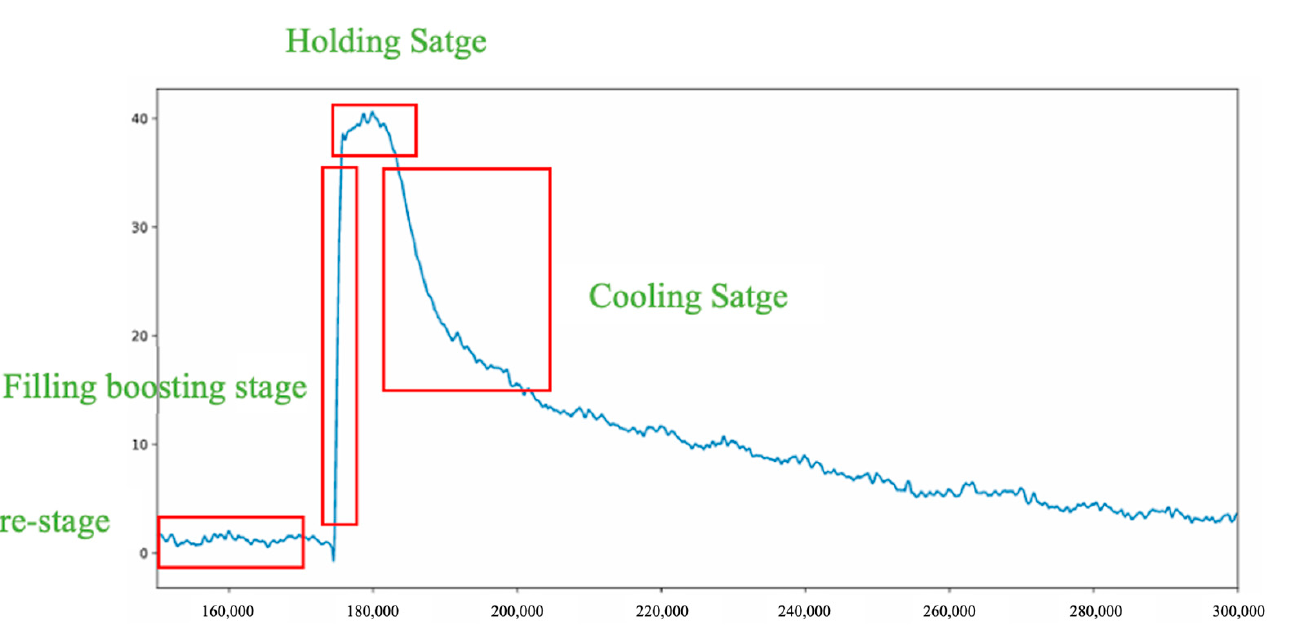
Figure 16. Pressure curve difference between non-defective and defective. The time point of the rapid drop is used as the start point location of each data ob- servation. To avoid waveform distortion and the other machine noises influencing the finding of the locating point, the maximum value of the smoothed data is used as a refer- ence point, and the data of 20,000 feature points before and after the reference point are